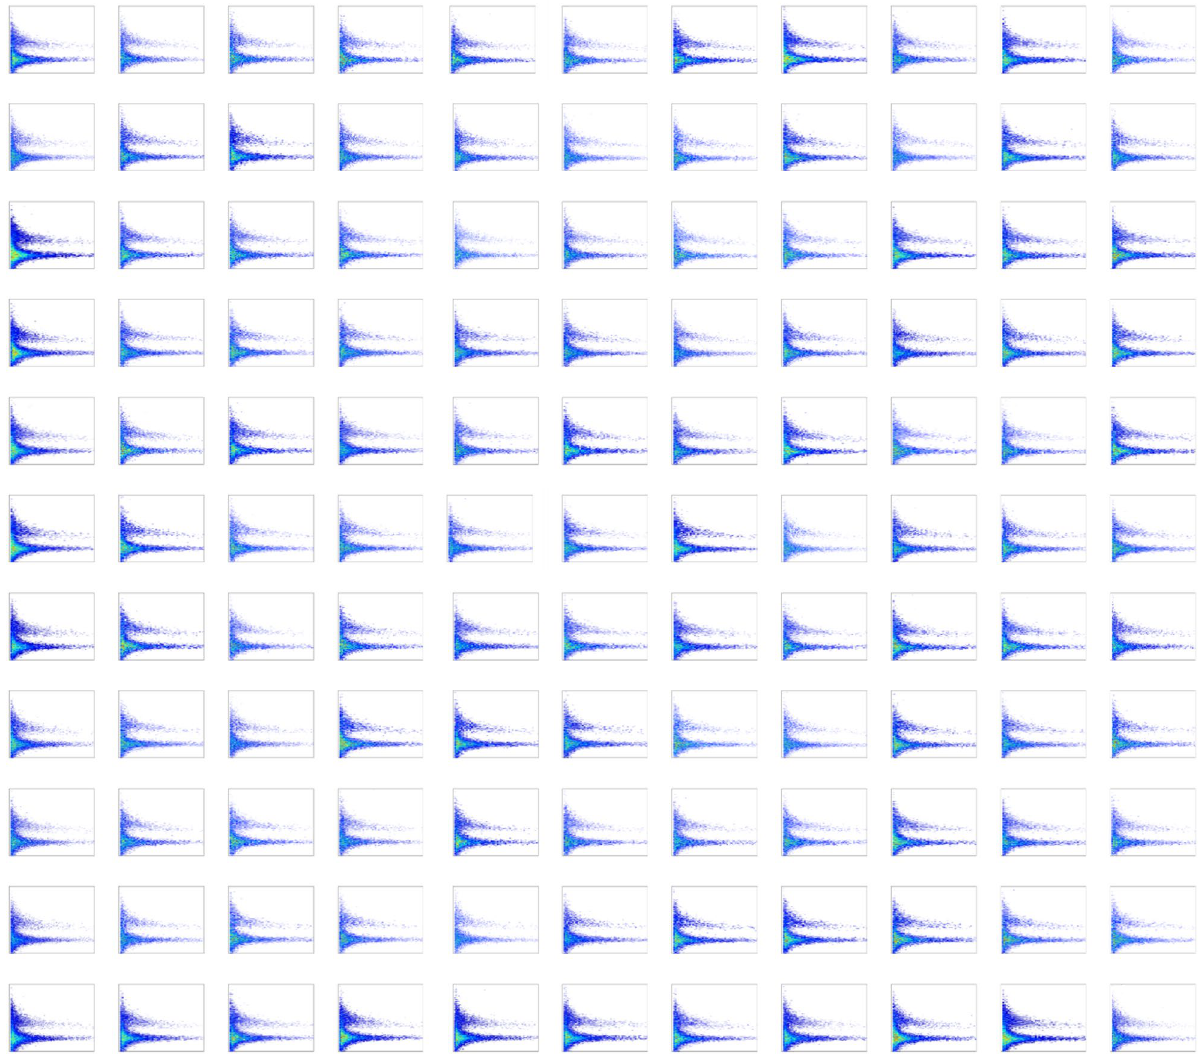
Figure 5. Pixel-by-pixel PSD plot for each 4 × 4 × 20 mm 3 stilbene scintillator pixel from which the overall detector PSD distribution in Fig. 4 is